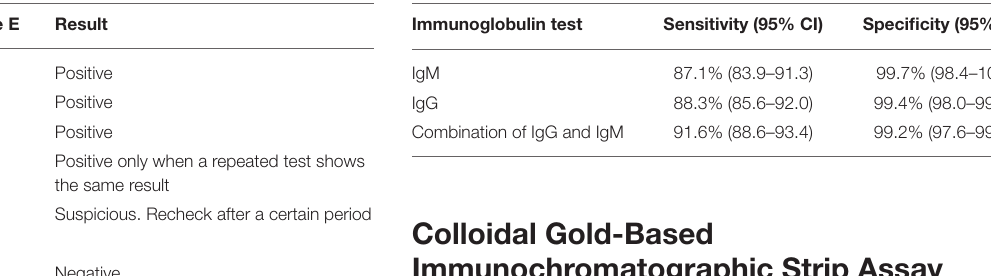
TABLE 2 | Sensitivity and specificity of the colloidal gold-based immunochromatographic strip assay (ICGSA). Immunoglobulin